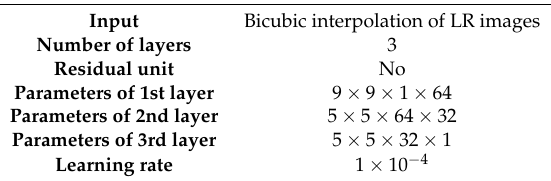
Table 1. Parameters of SRCNN used in this